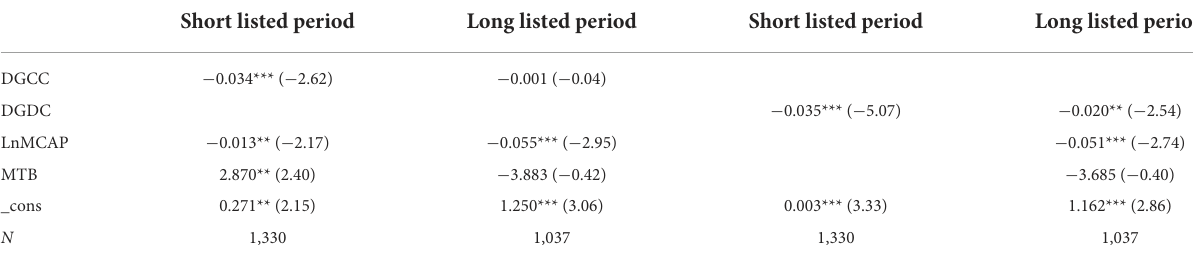
TABLE 9 The impact of firm age on market response to the COVID-19. Short listed period Long listed period Short listed period Long listed period